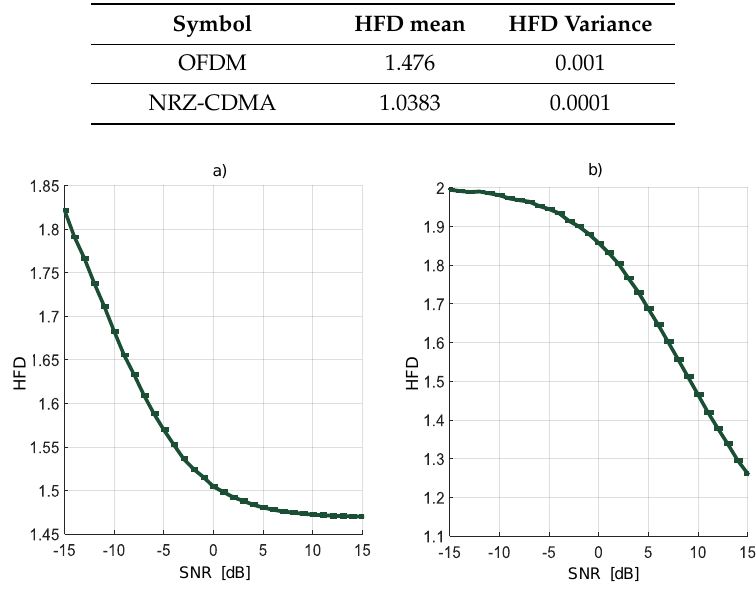
Figure 11. HFD of OFDM ( a ) and of NRZ-CDMA, ( b ) spectra with different SNR.